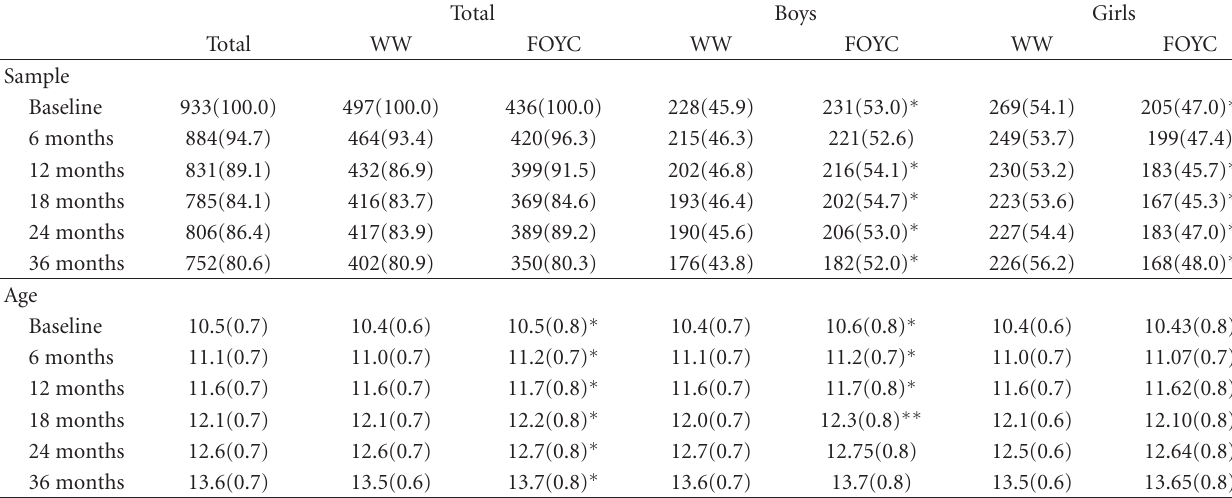
Table 1: Age (SD) and gender distribution (%) at baseline and across intervention conditions among 933 youth participating in the FOYC+CImPACT versus WW+GFI trial